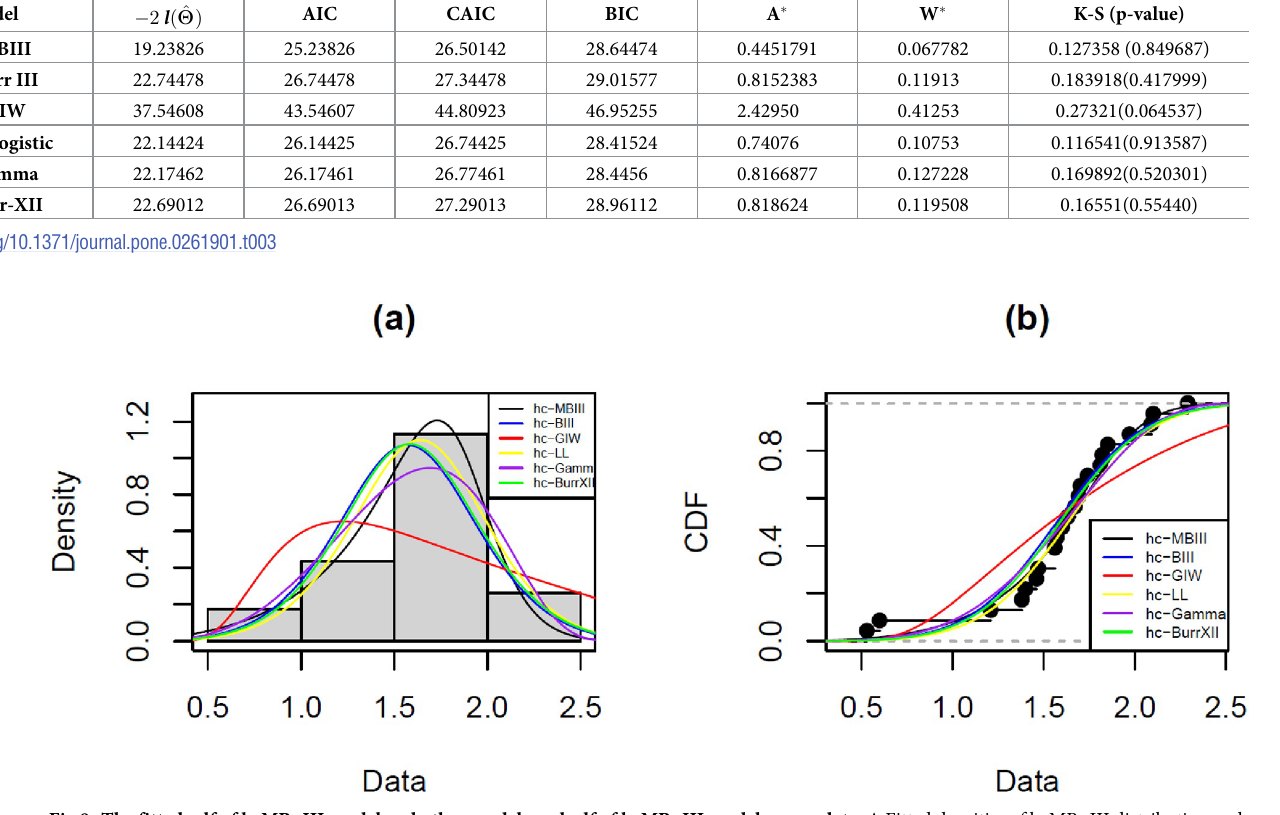
Fig 8. The fitted pdf of hcMB − III model and other models and cdf of hcMB − III model on eye data. A:Fitted densities of hcMB − III distribution and other models on eye data. B:Estimated cdfs of hcMB − III distribution and other models on eye data.